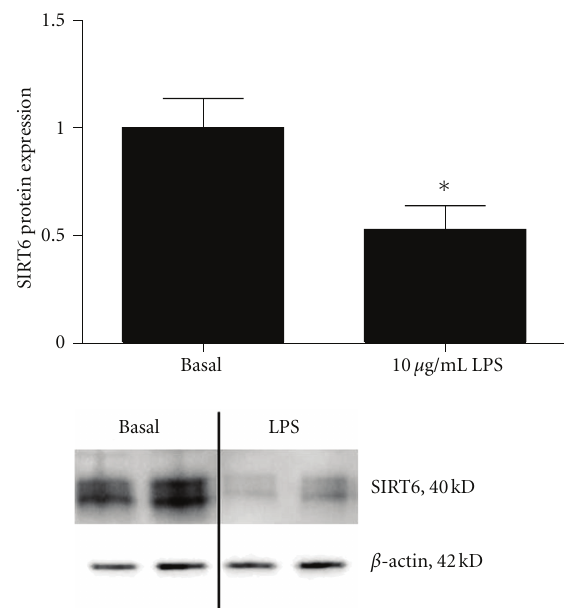
Figure 1: E ff ect of LPS on SIRT6 expression in HUVECs. HUVECs were incubated in the absence or presence of 10 μ g/mL LPS for 48h. SIRT6 protein was assessed by Western blotting and normalised to β -actin. Data is displayed as mean ratio of basal ± SEM ( n = 6 experiments). ∗ P < 0 . 05 versus basal (Student’s t -test). Two representative Western blot images are shown.